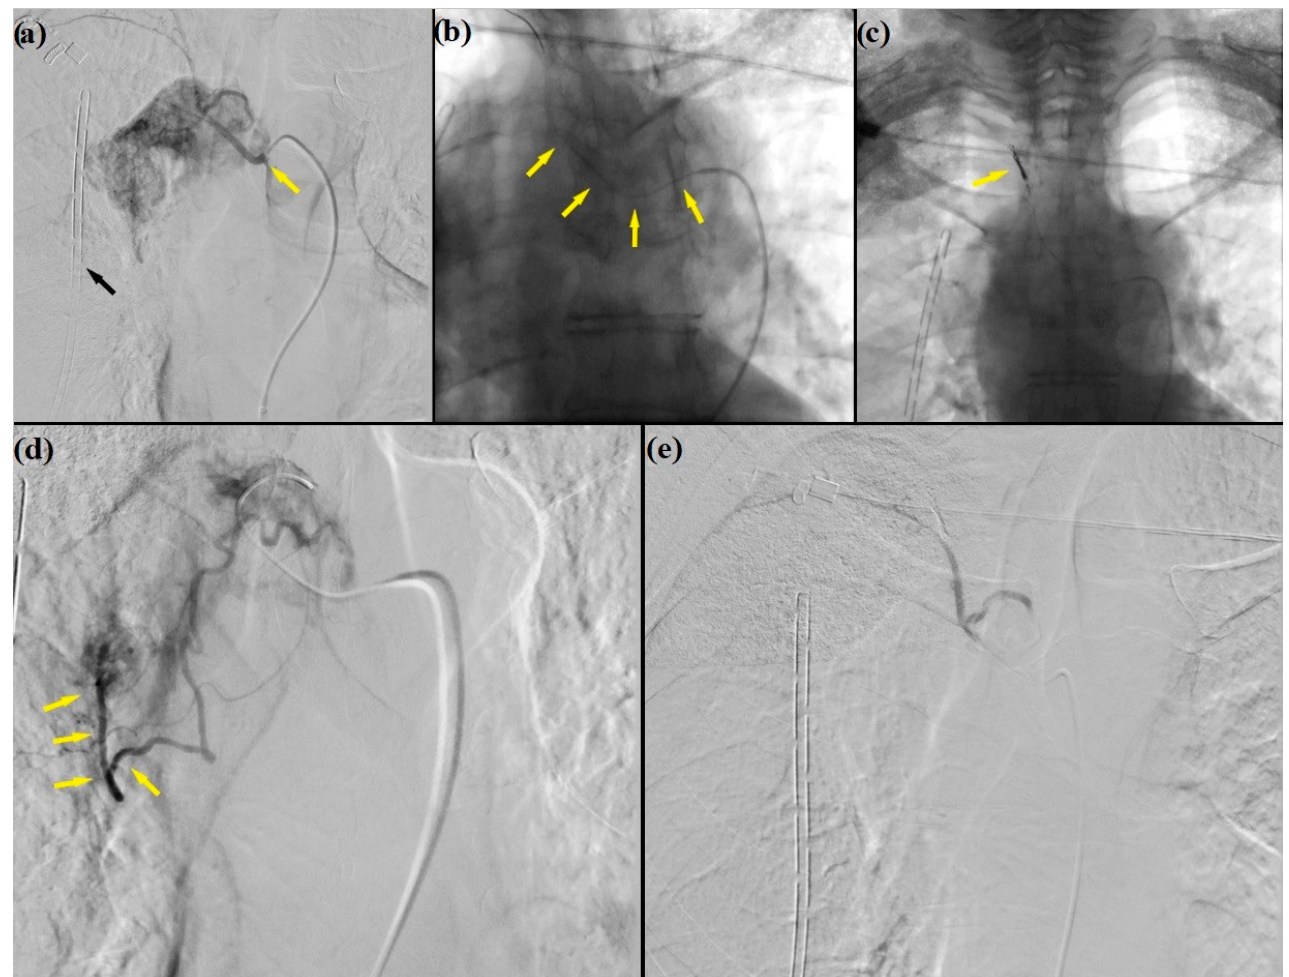
Figure 2. DSA and intra-arterial embolization: ( a ) catheterism (yellow arrow) of the right bronchial artery (Cobra Glidecath 4F, Terumo, Terumo Corporation, Tokyo, Japan) demonstrating a vascularized mediastinal mass and collateral image of the right pleural catheter (black arrow); ( b ) superselective catheterism (arrows) of an intercostal artery arising from the bronchial artery and; ( c ) subsequent embolization with micro coils (arrow) to avoid spreading of PVA particles; ( d ) superselective catheterism of main feeding artery and embolization with PVA particles (arrows) (Contour PVA 250–500 micron, Boston, Boston Scientific, Marlborough, MA, USA); ( e ) post-procedural DSA showing complete devascularization of the mass. DSA: Digital Subtraction Angiography; PVA: Polyvinyl Alcohol.